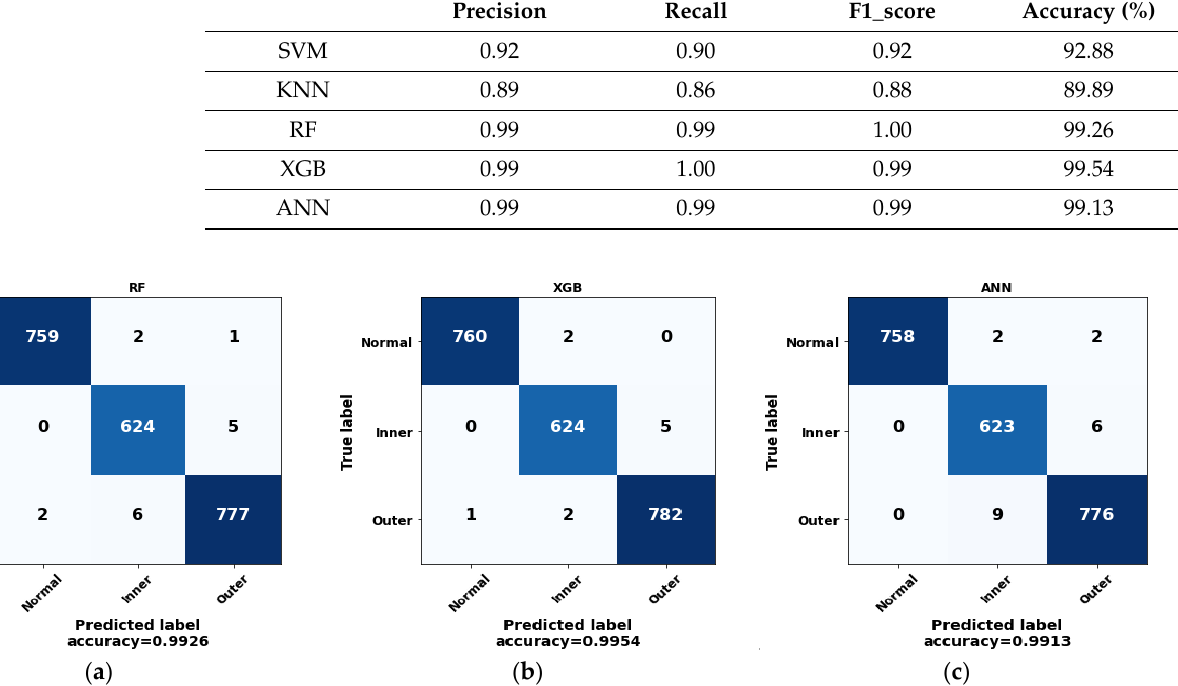
Figure 11. The accuracy ( a ) and loss curves ( b ) of the ANN model.